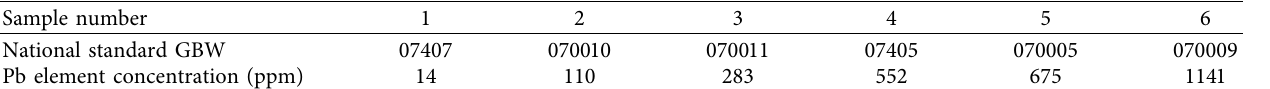
Table 4: Soil samples and their Pb content.